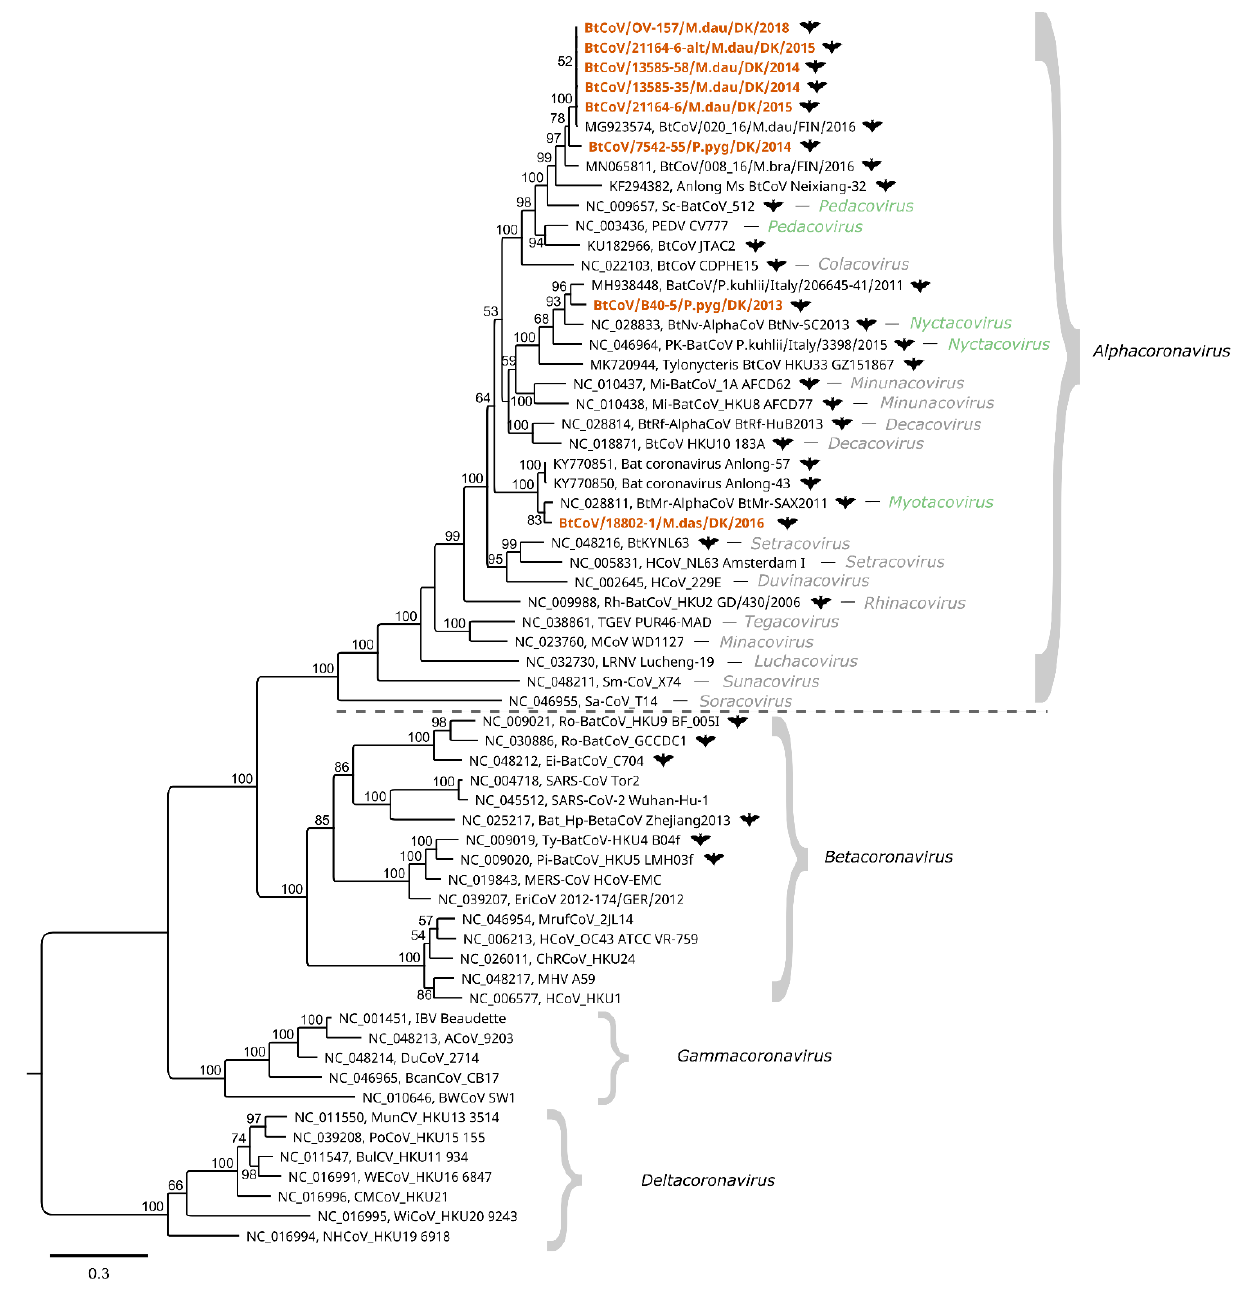
Figure 2. Phylogenetic tree of bat coronavirus sequences from Denmark. The sequences reported here (highlighted in orange) were compared to the closest matching sequences from GenBank and at least one ICTV exemplar isolate of each species of the Orthocoronavirinae subfamily. Bat coronavirus sequences are indicated with a bat symbol. The tree was generated using the PhyML maximum likelihood method with 100 bootstrap iterations on MUSCLE-aligned concatenated amino acid sequences predicted from the partial ORF1ab nt sequences (conserved regions of nsp5, nsp12, and nsp13), with a total length of 1224 amino acids. Only bootstrap values above 50 are displayed on the nodes. The evolutionary model for the tree was LG + G. The ICTV reference sequences have all been assigned to subgenera within the genera Alphacoronavirus , Betacoronavirus , Gammacoronavirus , and Deltacoronavirus . Clustering of the Danish bat coronavirus sequences indicates that they belong to the same subgenera as the reference sequences in the genus Alphacoronavirus , within the subgenera Pedacovirus , Nyctacovirus , and Myotacovirus (highlighted in green).